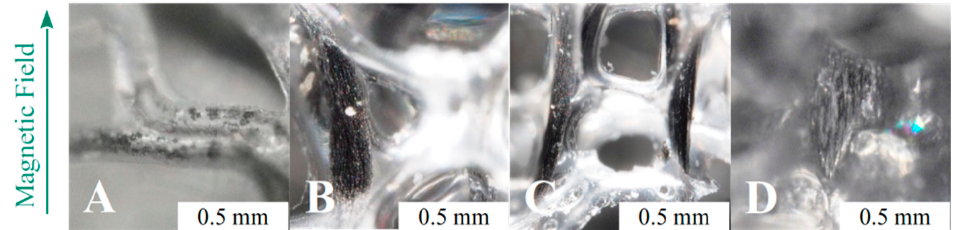
Figure 5. Details of the particles aggregates in samples after different MF time profiles: ( A ) RF, ( B )